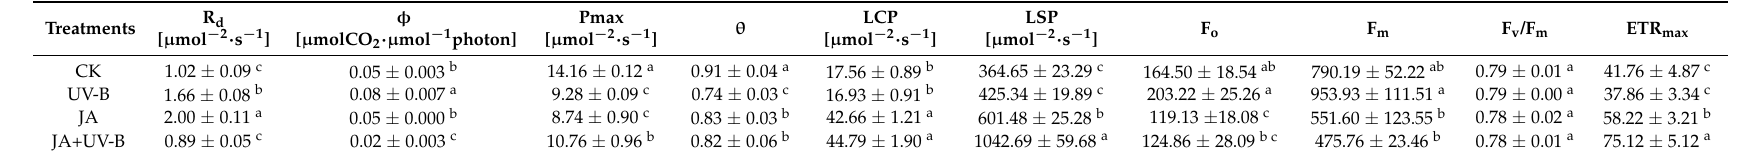
Table 1. JA and UV-B radiation effects on photosynthetic light response curves parameters and fluorescence parameters in Scutellaria baicalensis Georgi. leaf respiration (R d ), apparent quantum efficiency ( φ ), light saturated maximum photosynthesis (P max ), convexity ( θ ), light compensation point (LCP), light saturation point (LSP), the minimal fluorescence yield (F 0 ), the maximal fluorescence yield (Fm), the maximal efficiency of photosystem II (PSII) photochemistry (F v /F m ) and The maximum value of photosynthetic electron transport rate (ETR max ). CK (the control), JA (seedlings were sprayed with 1 mM JA), UV-B (seedlings were treated with 15-d elevated UV-B radiation), JA+UV-B (seedlings were sprayed with 1 mM JA before additional 15-d UV-B radiation). Data are means ± S.E., error bars are means of three replicates. Different lowercase letters are significantly different at p < 0.05 according to Duncan’s multiple range test.